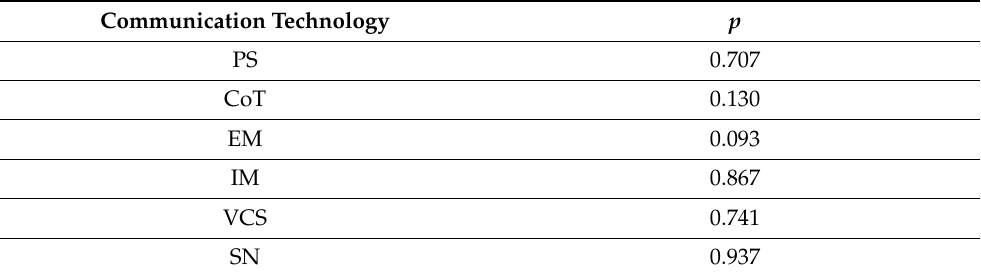
Table 15. Results of statistical inference t-test to verify the independence of student and teacher re- sponses to question 8 about the performance (attitude) using communication technologies ( p ≤ 0.05). Communication Technology